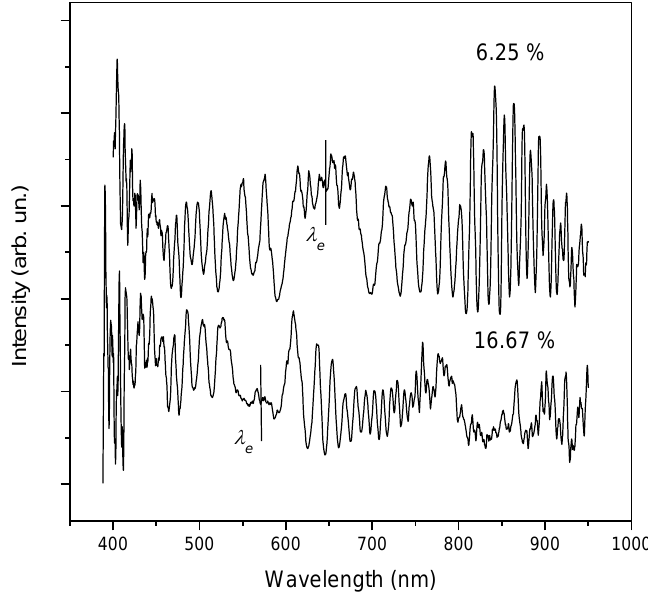
on the volume fraction in e